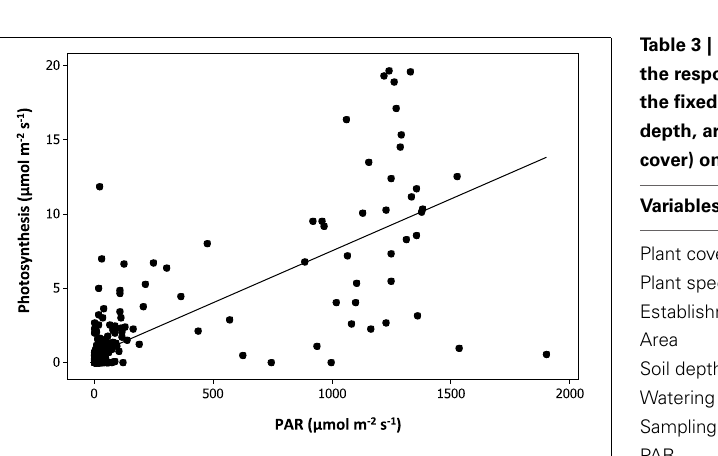
FIGURE 3 | Modeled relationship between plant cover (%), plant species richness and irrigation levels depending on the sampling time period.